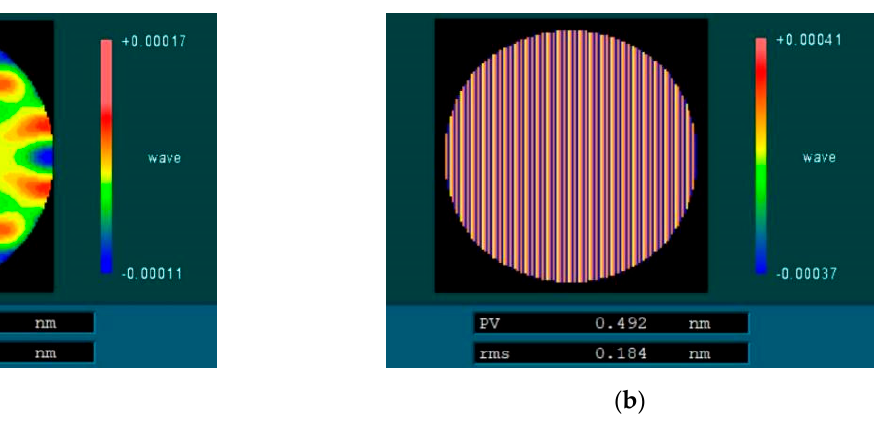
Figure 5. Surface mid-spatial frequency error after simulation processing. ( a ) Surface PSD1 error after simulation processing. ( b ) Surface PSD2 error after simulation processing.